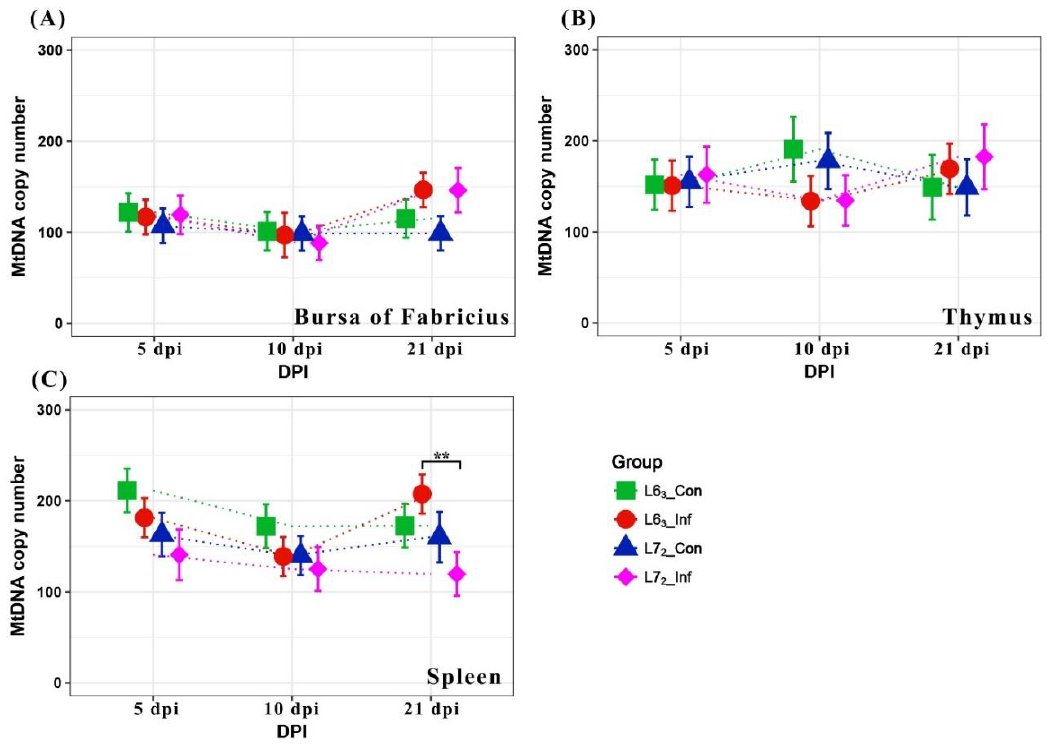
Figure 1. The mitochondrial DNA (mtDNA) copy number variation (means ± standard error) over three time-points. ( A ), ( B ) and ( C ) show the mtDNA abundance in bursa of Fabricius, thymus, and spleen, respectively. MtDNA copies per cell were generated with ND2 and β -actin qPCR data. Birds used in each group were five. The symbols * and ** indicate statistical significance at p ≤ 0.05 and p ≤ 0.01 levels, respectively, between lines or treatment groups.